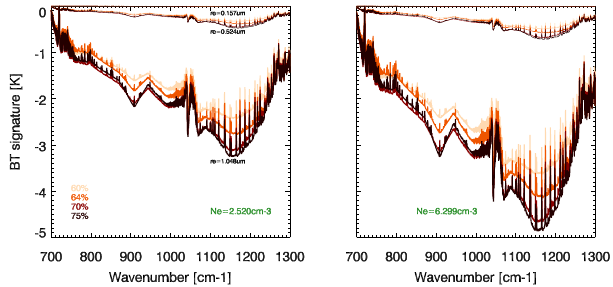
Figure 6. BT signature of sulfate aerosol layers, for effective number concentrations of 2.52 (left panel) and 6.30particlescm − 3 (right panel), for effective radii of 0.16, 0.52 and 1.05µm (see text in the figures) and H 2 SO 4 mixing ratios of 60, 64, 70 and 75% (in different colours).